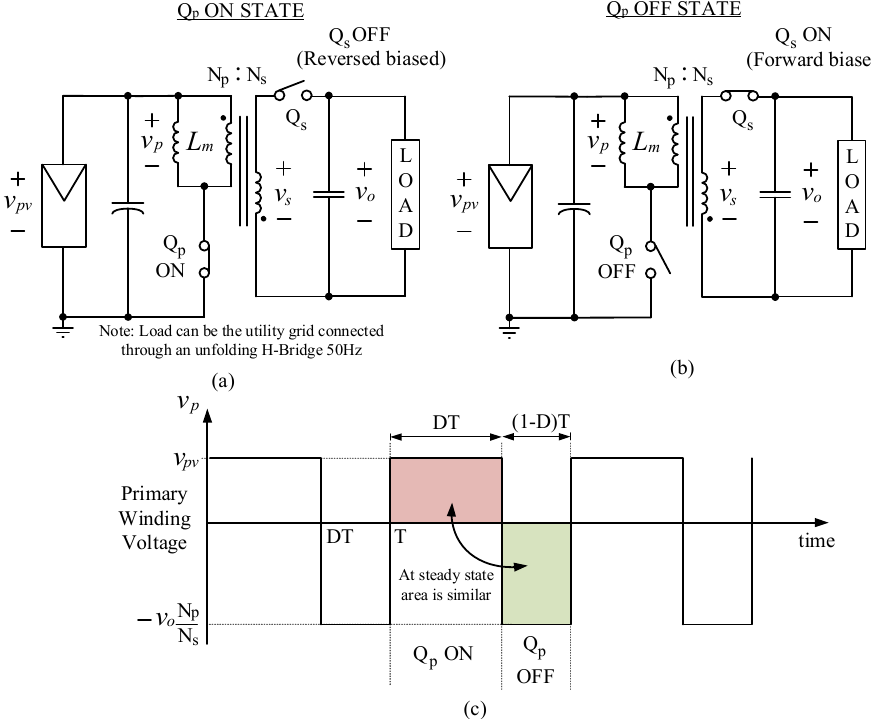
Figure A1. General flyback ON and OFF state. ( a ) ON State ( b ) OFF State ( c ) Primary winding voltage during both ON and OFF state.